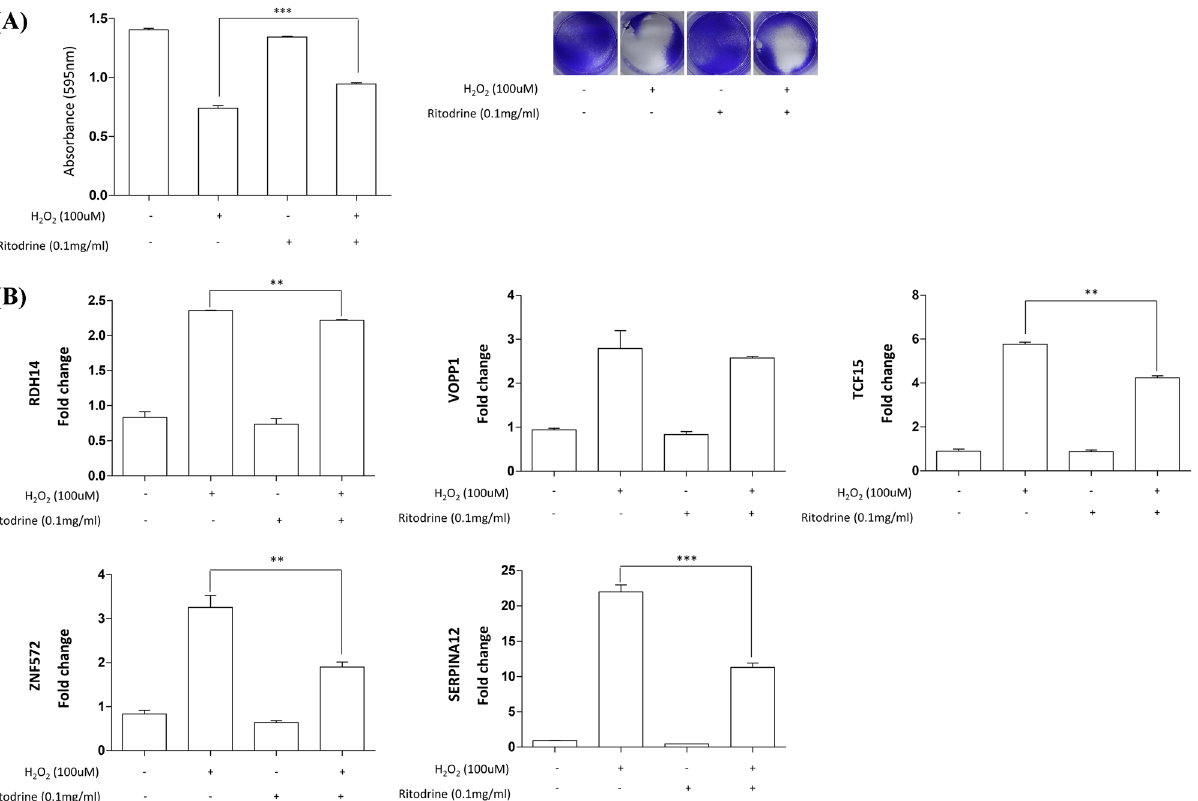
Figure 7. Effect of ritodrine on the cell viability (A) and mRNA expression of candidate genes (B) in H 2 O 2 - treated HTR-8/SVneo cells. Asterisks indicate levels of significance of differential expression (** P ≤ 0.01, *** P ≤